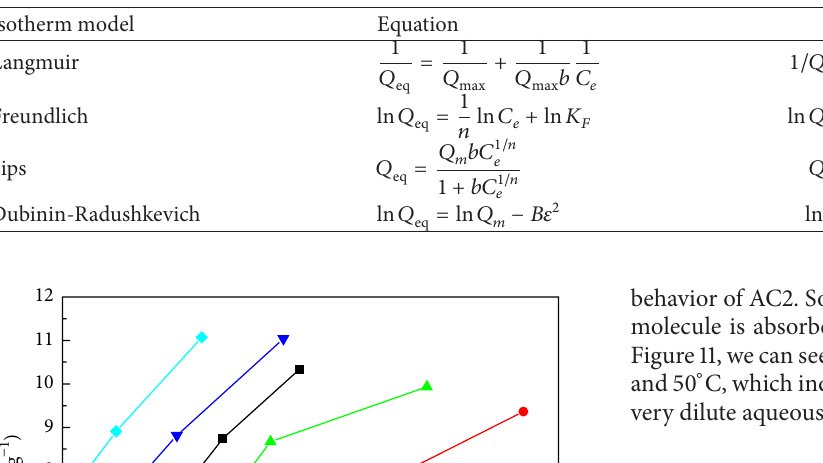
Table 3: Isotherm models and their equations.